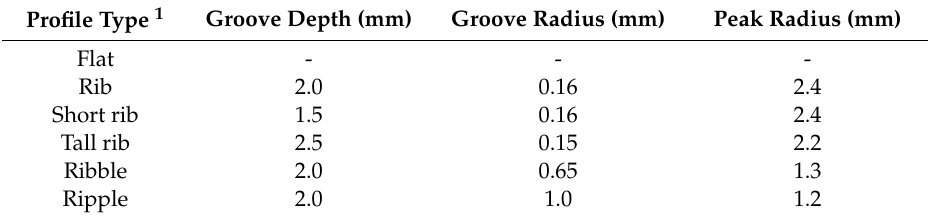
Table 1. Geometry of profiles in western larch